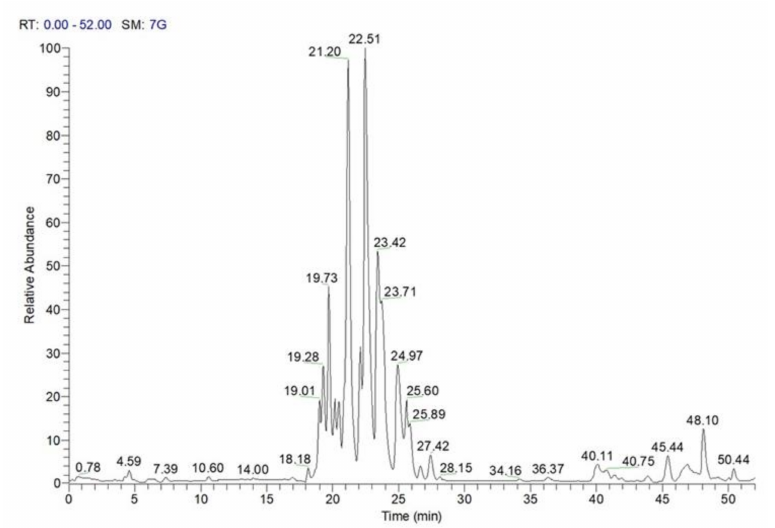
Figure 4. LC-ESI/LTQOrbitrap/MS profile (negative ion mode) of the MeOH extract of “Marrone di Roccadaspide” PGI